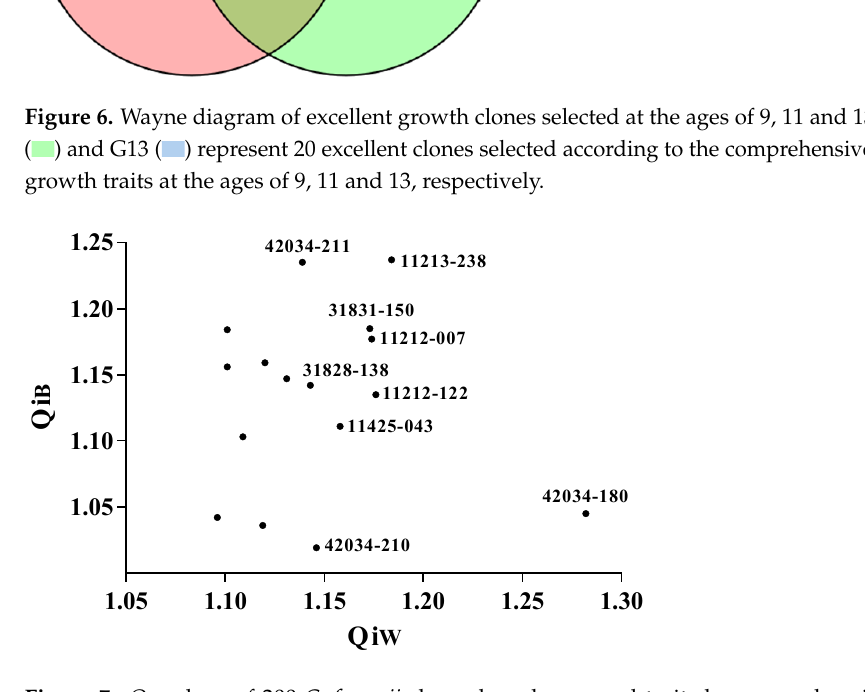
Figure 7. Q i values of 200 C. fargesii clones based on wood traits by comprehensive evaluation meth- ods. Q iB , Comprehensive evaluation of the breeding values of the Pilodyn value and MOE; Q iW , comprehensive evaluation of the Pilodyn value and MOE. 1.05